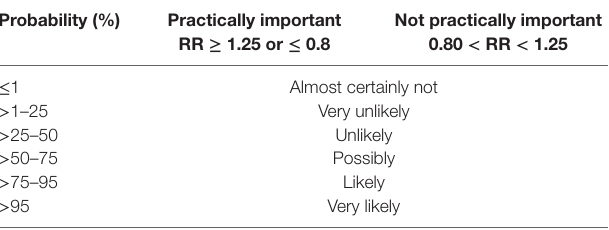
TaBle 2 | Qualitative interpretations of the probabilities that the population RR lies in the given